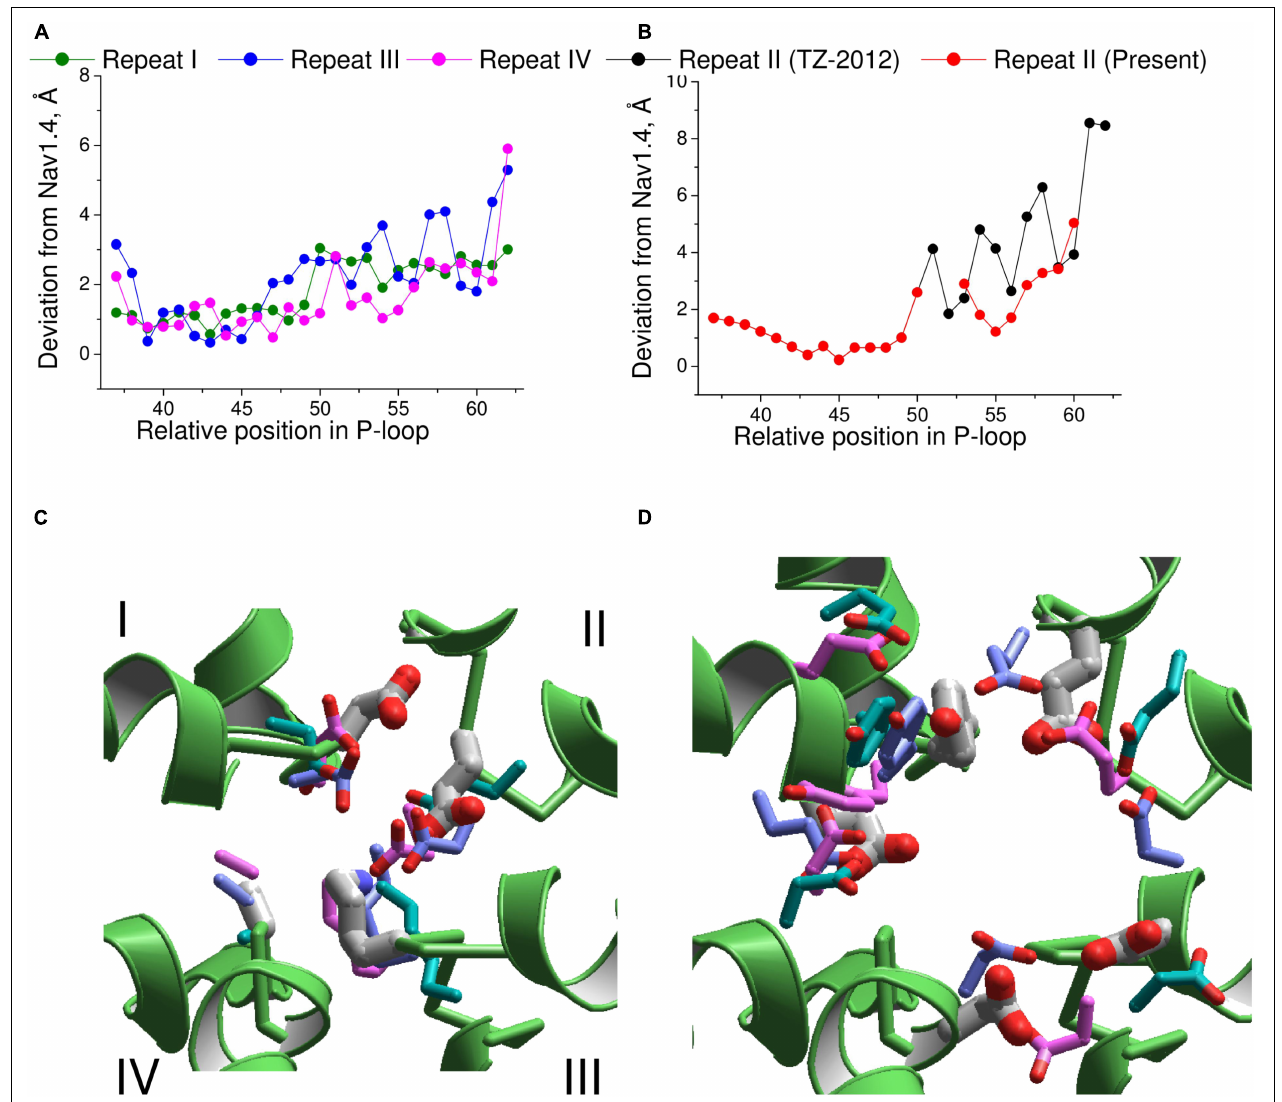
FIGURE 7 | Comparison of the Nav1.4 cryo-EM structure with homology models. (A) P-loop alpha carbons in repeats I, III, and IV of the NavAb-based model (Tikhonov and Zhorov, 2012) are close to the matching atoms in the Nav1.4 structure. (B) In repeat II, big irregular deviations are seen because the Nav1.4 sequence aligned with NavAb lacks deletion at position 54 ( Figure 6A ). Introducing this deletion reduced deviations and the curve becomes similar to those in other repeats. (C) Side chains of the DEKA ring in 3D aligned structures. Only the Nav1.4 backbone is shown. The Nav1.4 residues are shown as thick sticks. Residues in the KcsA-based models (Lipkind and Fozzard, 2000; Tikhonov and Zhorov, 2005a) and NavAb-based model (Tikhonov and Zhorov, 2012) are shown, respectively, with cyan, magenta, and violet thin sticks. (D) Side chains of the outer carboxylates and a TTX-interacting tyrosine in position 51 of repeat I. Residues are rendered as in (C)